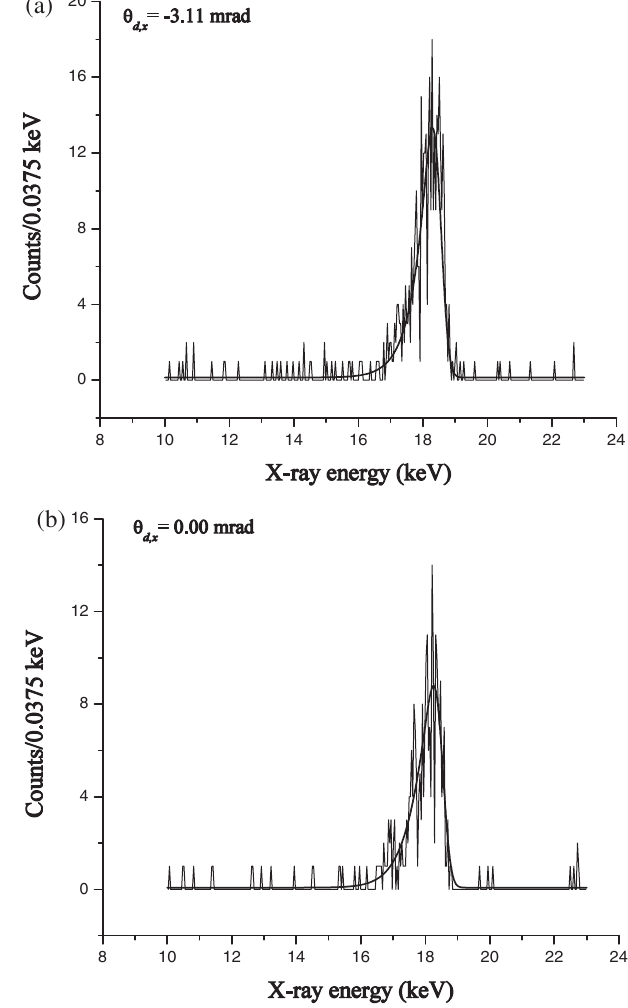
FIG. 11. (a),(b) LCS experimental spectra together with the simulated LCS spectra [Eq. (3)] generated using the electron beam parameters determined from the minimization method for detector vertical angles equal to (cid:6) 3 : 11 and 0 : 00 mrad , respec- tively. The x-ray absorption in SS window and air and the detector efficiency were included in the simulations.